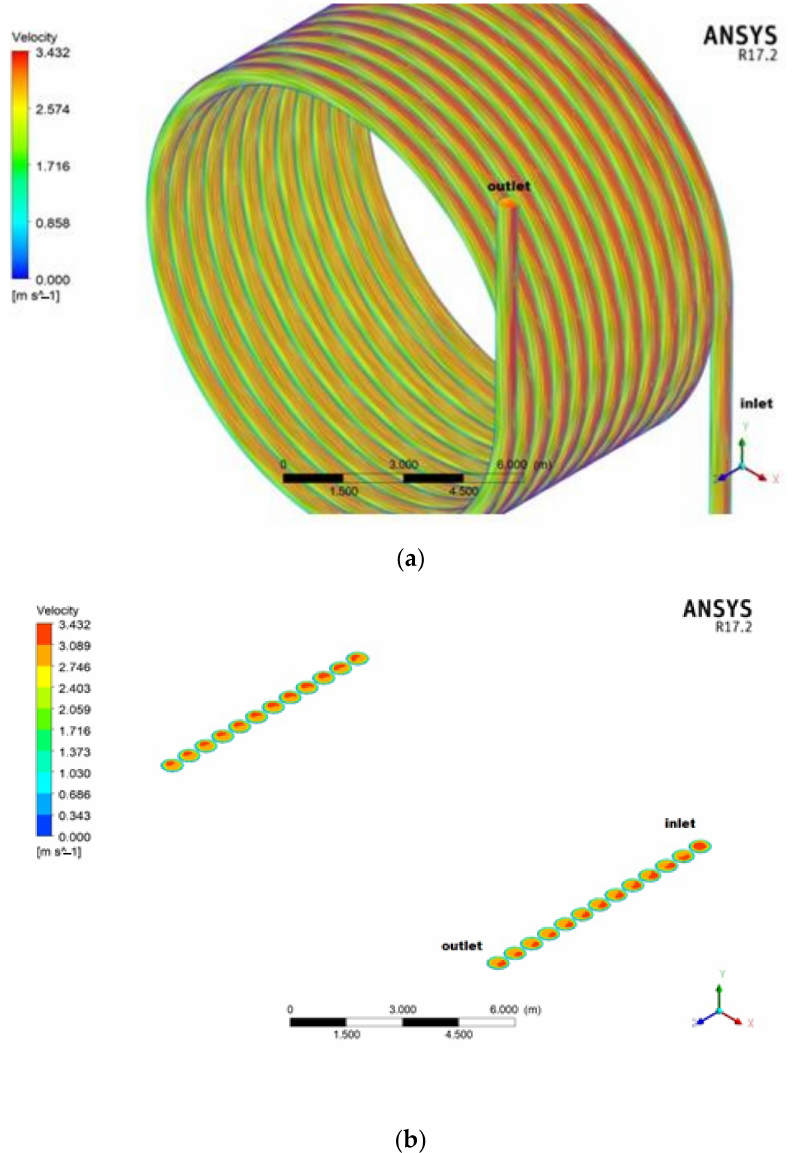
Figure 10. The simulation results, received in postprocessing: ( a ) velocity field in the coil, ( b ) the same velocity field in the coil, but in a horizontal